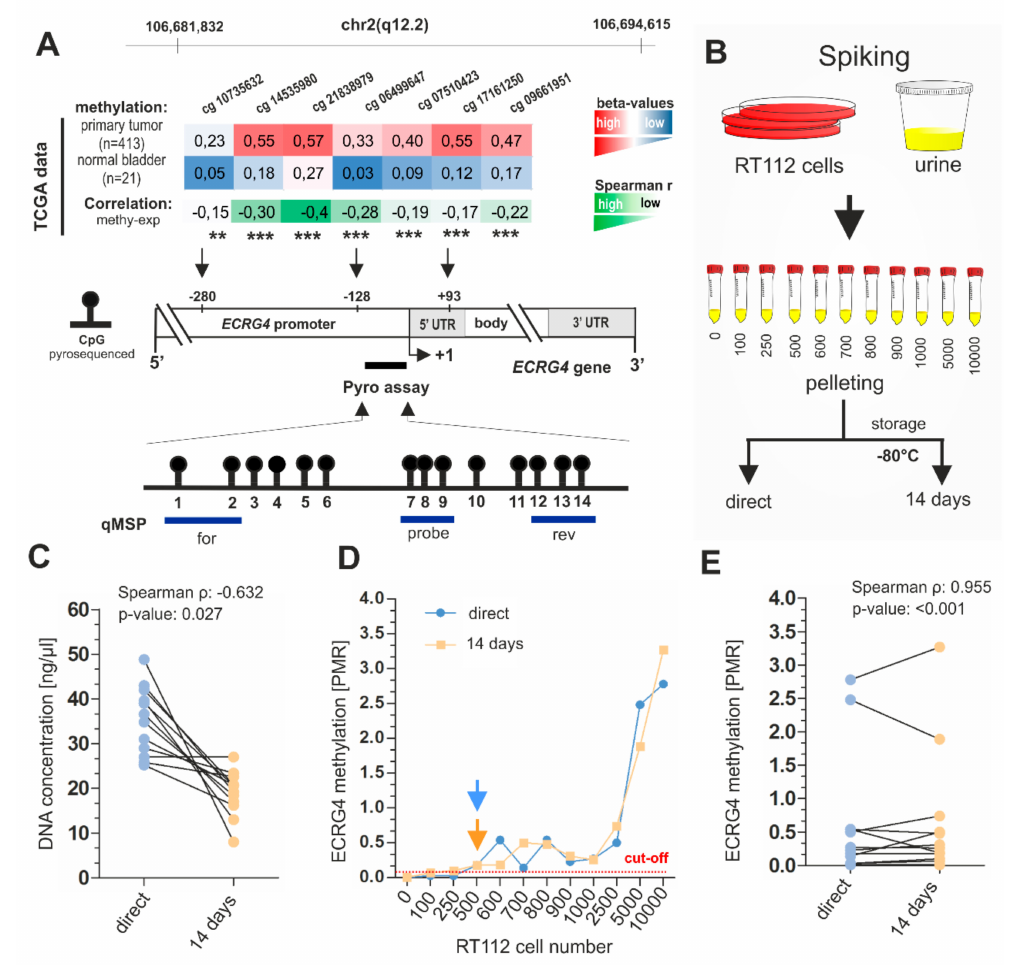
Figure 1. Analytical performance of the Quantitative Methylation-Specific PCR (qMSP) ECRG4 DNA methylation biomarker assay. ( A ) Schematic map of the human ECRG4 gene, including the relative positions and median β -values (of normal and tumor samples) of seven CpG sites based on 450K methylation arrays of the bladder cancer (BLCA) TCGA data set and corresponding Spearman correlation between ECRG4 methylation (colored scale bar red to white; red: high methylation, white: low methylation) and ECRG4 mRNA expression (colored scale bar green to white; green: strong correlation, white: no correlation) for each CpG site; ** p ≤ 0.01, *** p ≤ 0.001. + 1: ECRG4 transcription start site (TSS). Relative position of the promoter area analyzed by bisulfite-pyrosequencing that comprises 14 single CpG sites (black dots) is shown as a black line. CpG sites analyzed by qMSP (blue lines) were indicated covering the pyrosequenced promoter region close to the TSS. ( B ) Cartoon illustrating the spiking experiment using cultured RT112 tumor cells and urine pooled from four healthy donors. Distinct cell numbers of RT112 tumor cells (100-10,000) were spiked into 20 mL urine, respectively. Afterwards, urine samples were processed according to the standard operating protocol of the RWTH cBMB biobank. Pellets of probe set A were directly used for DNA extraction while urine sediments of probe set B were stored according to the RWTH cBMB conditions ( − 80 ◦ C) for two weeks before further processing. ( C ) Comparison of DNA concentrations ( = yield) achieved of samples from probe set A (direct processing) and B (after 14 days). DNA yield was significantly higher in freshly processed urine samples. ( D ) ECRG4 promoter methylation determined by using qMSP of spiked urines samples. Red dotted line: threshold value for positive detection; orange and blue arrow: stably exceeding the threshold (detection limit) ( E ) Correlation of ECRG4 DNA methylation for spiked urine samples of probe set A and